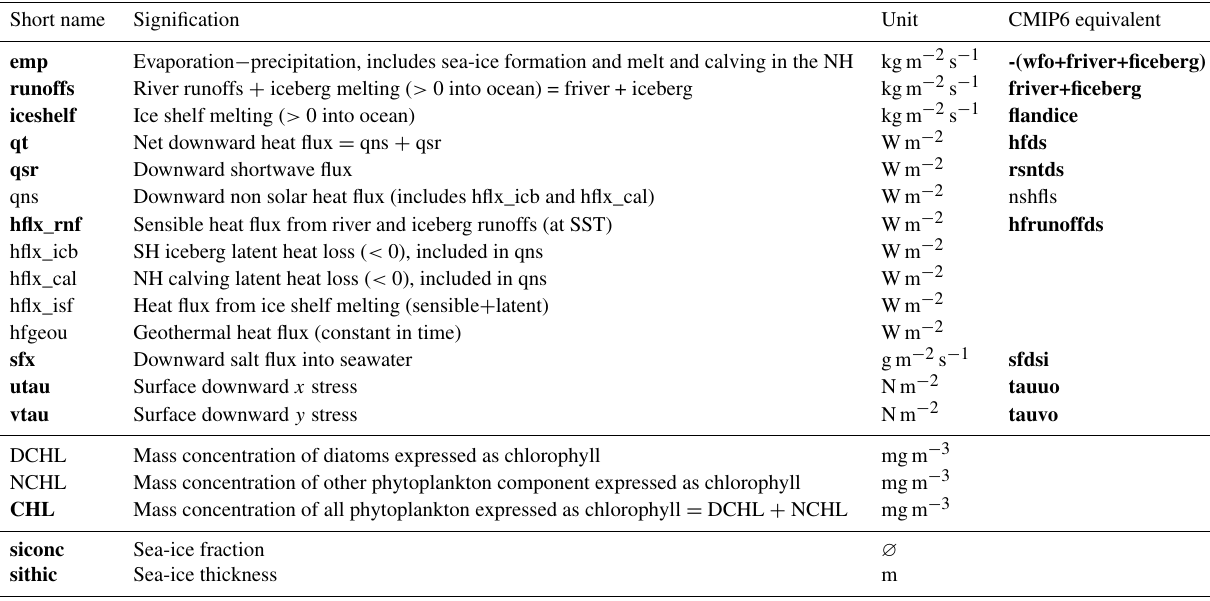
Table 1. Exchanges between the ocean and the other components in the IPSL-CM6A-LR coupled model and their signification. The terms in bold are those read from the coupled model outputs to force the stand-alone ocean model in a fixed-flux configuration. The corresponding CMIP6 terms are given in the right column, indicating the terms needed to compute the flux